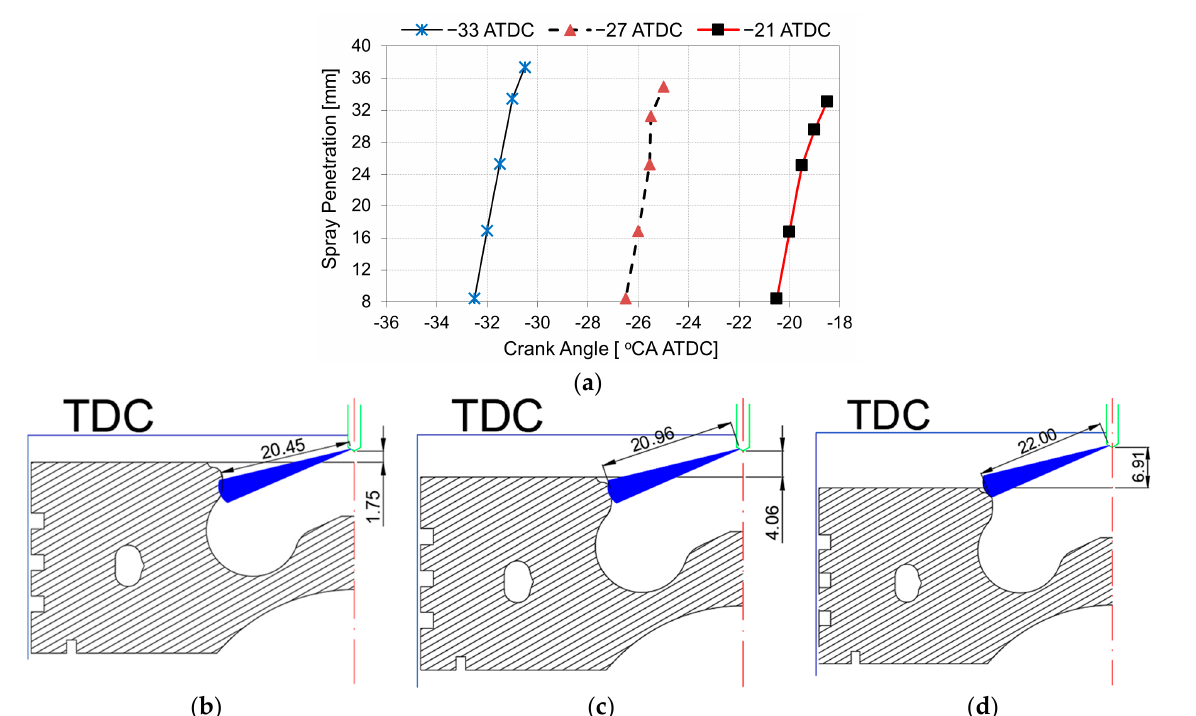
Figure 10. ( a ) Spray penetration lengths at different SOIs; spray penetration analysis showing spray impingement positions on the piston bowl, piston lip and squish regions 1.5 °CA after the commanded SOI timing with ( b ) − 21 °CA ATDC SOI ( c ) − 27 °CA ATDC SOI and ( d ) − 33 °CA ATDC SOI under naturally aspirated condition (100 kPa absolute intake pressure). The distance from the injector to the spray tip is in mm.